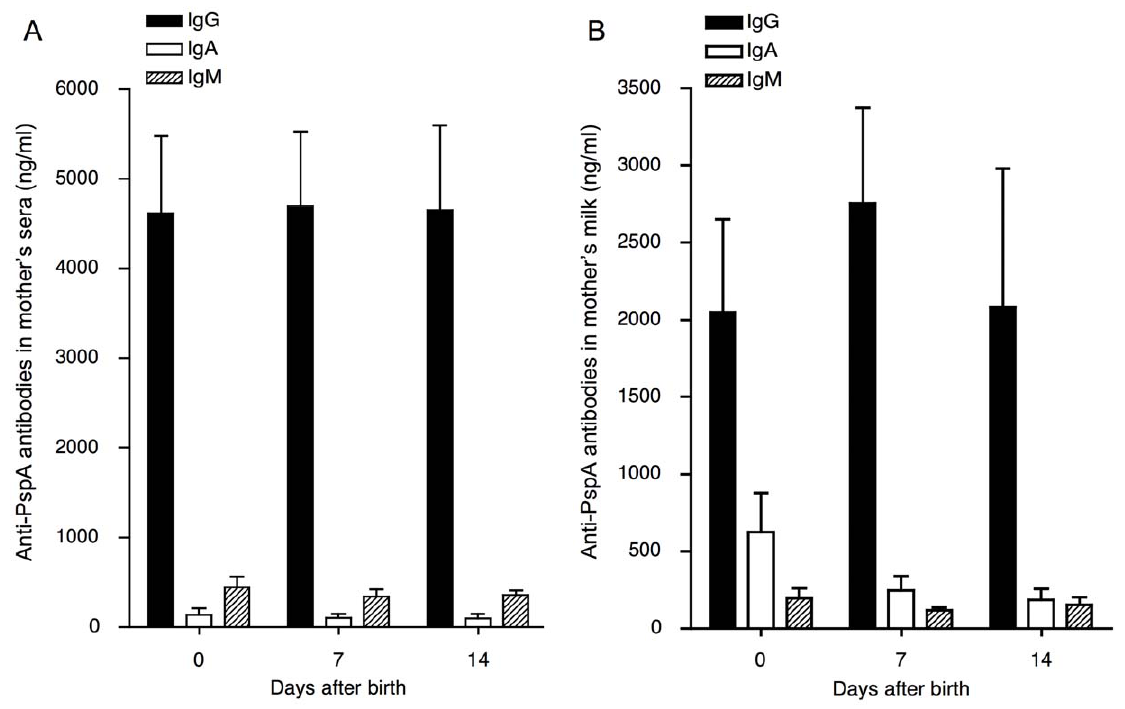
Figure 1. Anti-PspA specific antibodies in sera and milk of mother mice. Female mice were intranasally immunized twice each week with 1 m g of rPspA and 4 m g CTB for first 2 weeks and with 1 m g rPspA alone for the last week. The levels of anti-PspA specific IgG, IgA and IgM antibodies in sera (A) and breast milk (B) were determined by PspA-specific ELISA on day 0, 7 and 14 after the birth. The values shown are the mean 6 S.E. concentrations (ng/ml) taken from PspA-immunized mother (n=16) and sham-immunized mother (n=14). The levels of anti-PspA specific antibodies in sera and breast milk from sham-immunized mice were below the limit of detection.